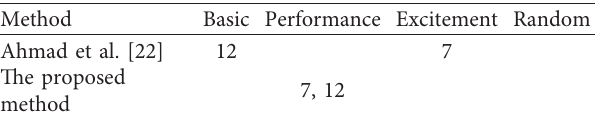
Table 8: Attributes with different categories as defined by the method proposed by Ahmad et al. [22] and the proposed method. Two attributes have different categories.